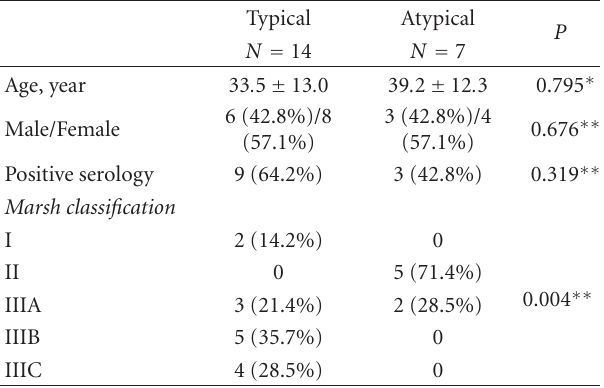
Table 2: Patients with CD and typical/atypical